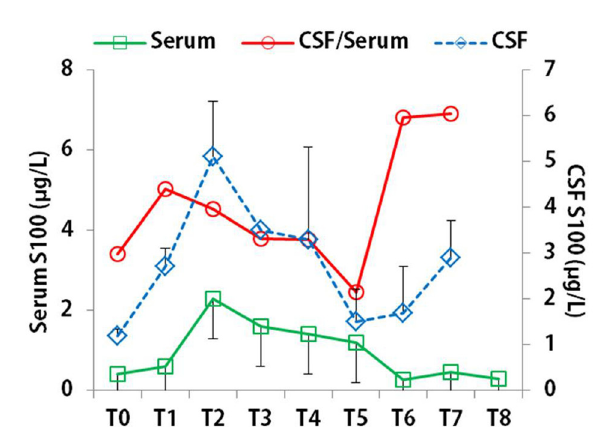
Fig. 1 - Dynamics of CSF S100, serum S100 and CSF/serum